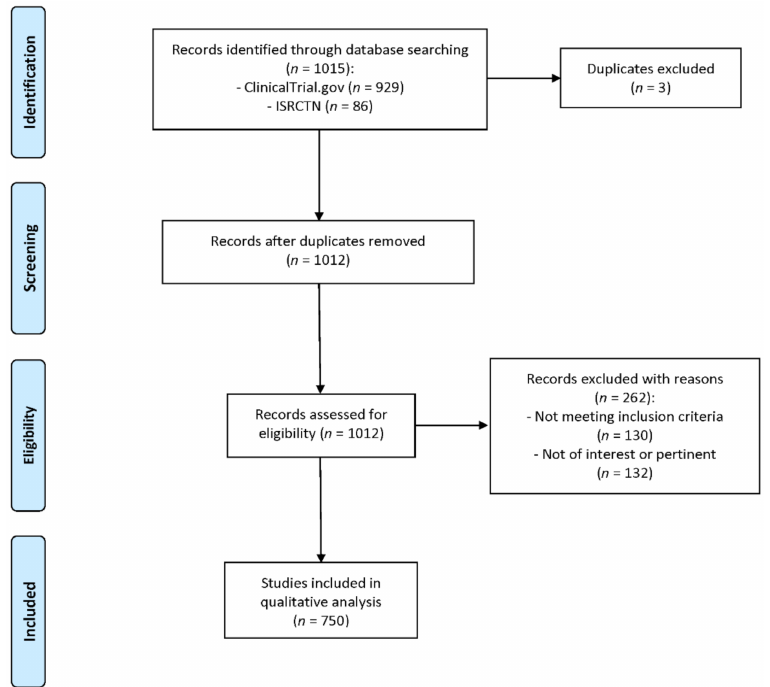
Figure 1. Flow diagram of the literature search process. Legend: ISRCTN: International Standard Randomised Controlled Trial Number.